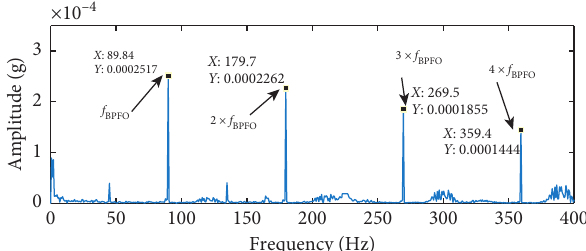
Figure 18: Experimental signal for ER-16K under 1500rpm.